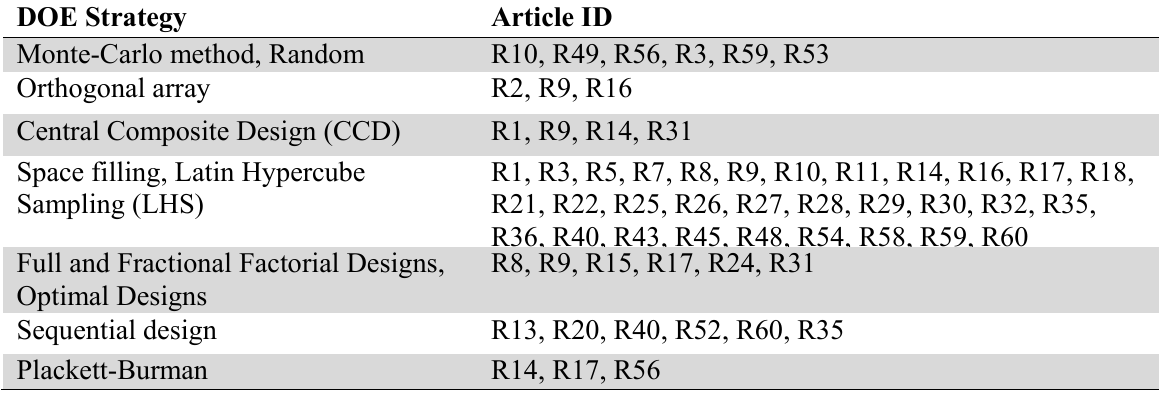
Different strategies of DOE for SO in literature.